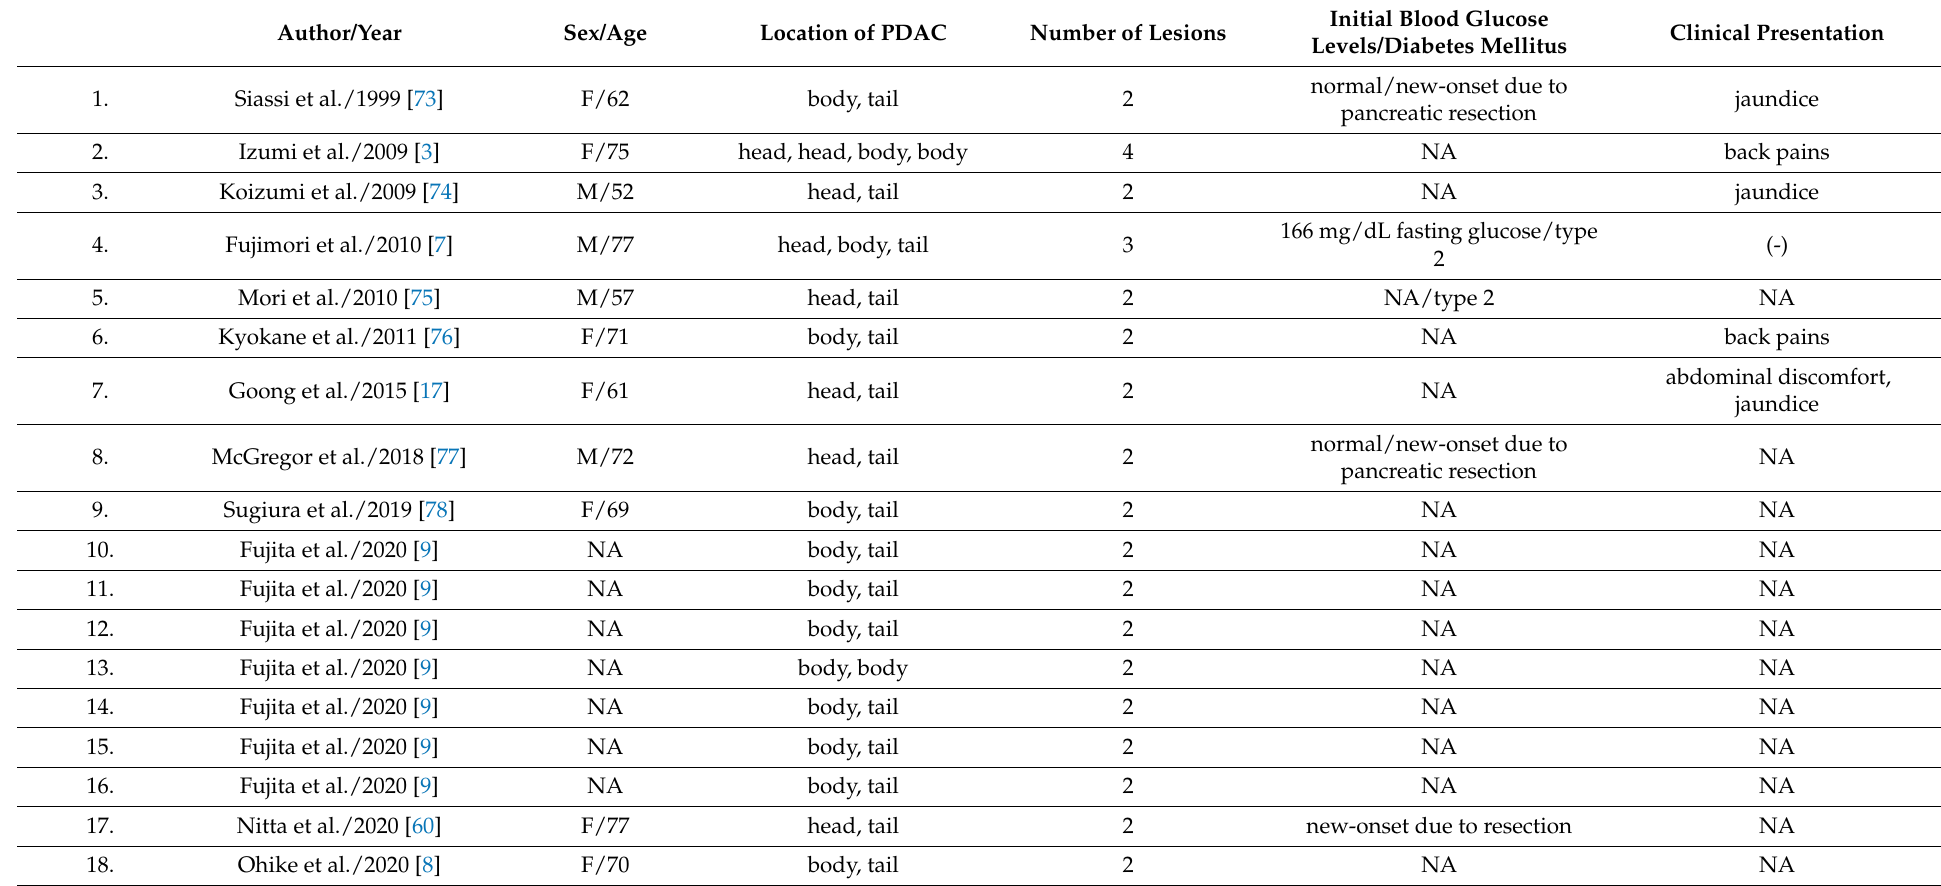
Table 1. Summary of the cases of synchronous primary pancreatic ductal adenocarcinoma reported in the